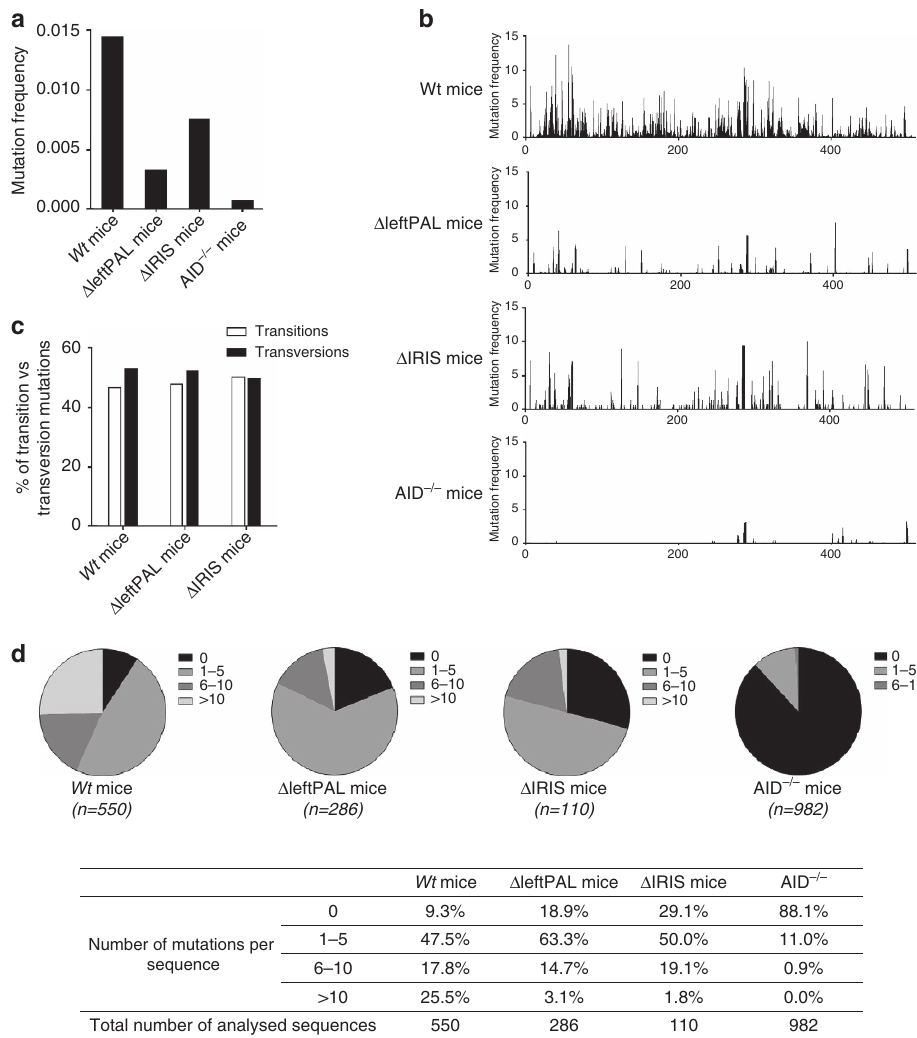
Figure 2 | Influence of the 3’RR palindrome on SHM. ( a ) SHM in V H regions of D leftPAL, D IRIS and wt mice. Mice were immunised orally with sheep red blood cells for 2 weeks and intraperitoneally with 10 m g of LPS for 3 days. B220 þ GL7 þ Fas þ cells from Peyer’s patches were sorted and pooled, and extracted DNA was amplified by PCR and submitted to high-throughput sequencing to evaluate SHM. V H SHM values were normalised to J k 5 SHM values. Mean values from six mice for all genotypes were reported (8–12 weeks old, male and female). ( b ) SHM were found all along the analysed 3’ J H4 DNA segment and hot spot of mutations were evidenced in both genotypes. Same mice as in a . ( c ) The proportion of transitions and transversions did not significantly differ between wt , D leftPAL and D IRIS mice. Same mice as in a . ( d ) Percentages of sequences with 0, 1–5, 6–10 and 4 10 mutations. (n): number of analysed sequences. Same mice as in a